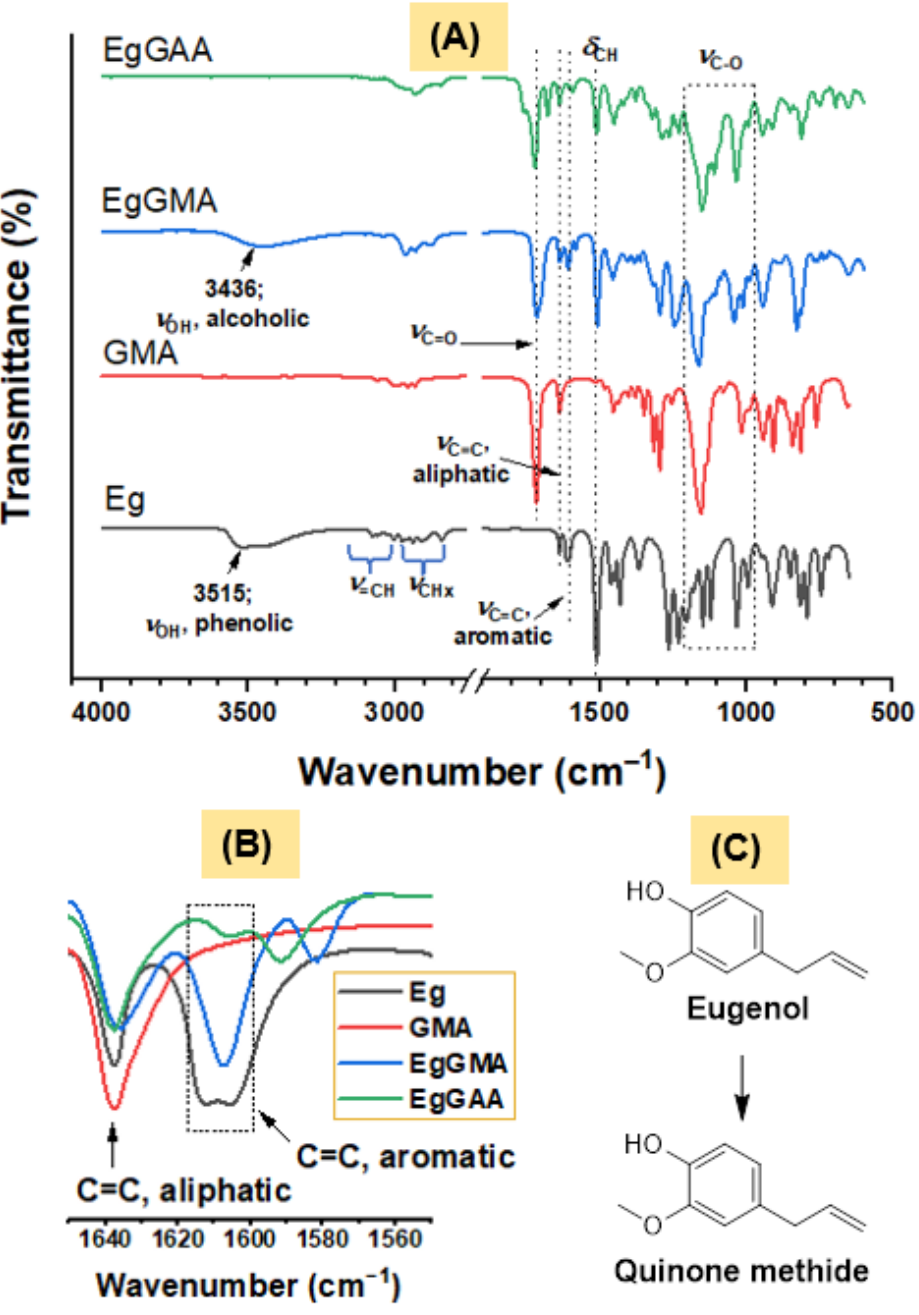
Figure 2. ( A ) FTIR spectra of Eg, GMA, EgGMA and EgGAA. ( B ) Spectral range of C=C bonds. ( C ) Eugenol and quinone methide structures. ( C ) Eugenol and quinone methide